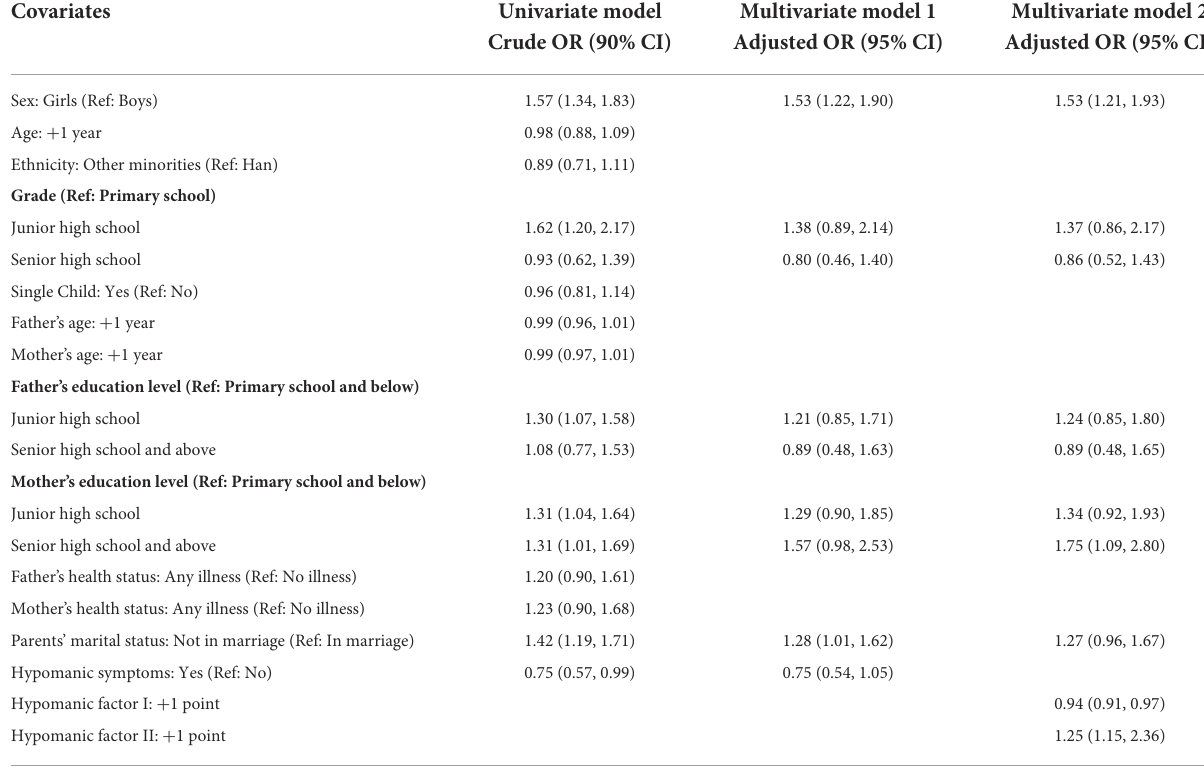
TABLE 2 Univariate and multivariable logistic regression models fitting results for SH. Covariates Univariate model Multivariate model 1 Multivariate model 2 Crude OR (90% CI) Adjusted OR (95% CI) Adjusted OR (95%